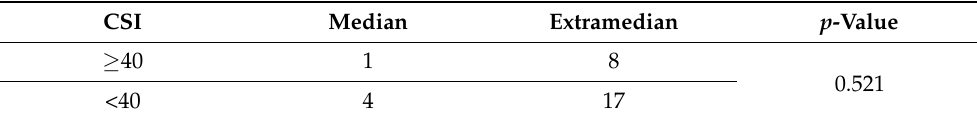
Table 4. Association between CSI and symptom spread.